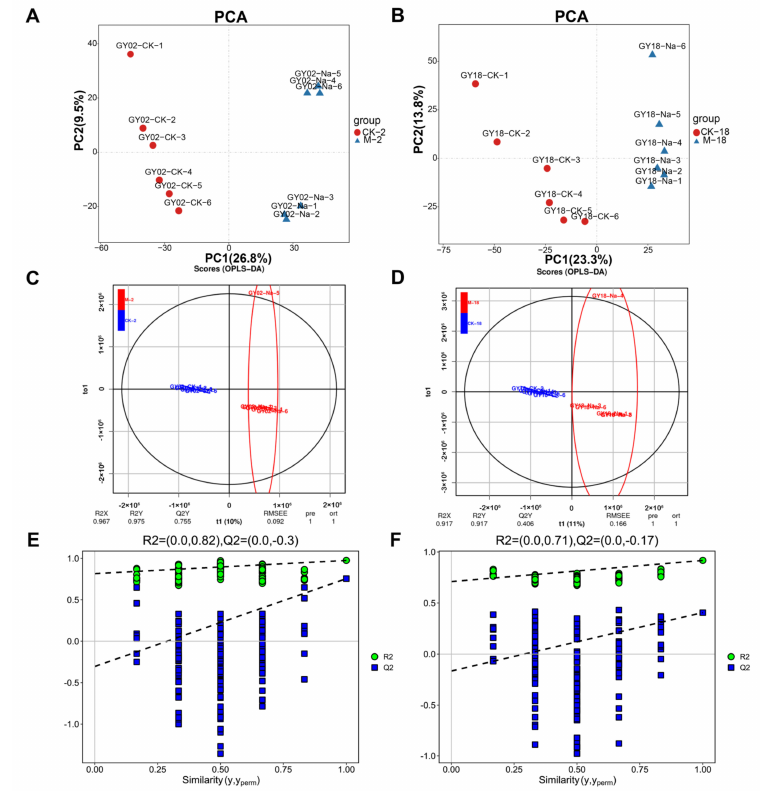
Figure 5. PCA score map ( A , B ), OPLS-DA scores ( C , D ) and permutation test ( E , F ) in positive ionization mode (POS). PCA score map of ( A ) GN2 and ( B ) GN18. ( C ) Scores of the OPLS-DA model in GN2 and ( D ) GN18. OPLS-DA cross-validation in ( E ) GN2 and ( F ) GN18. R 2 Y and Q 2 denote the rate of the model interpretation of the Y matrix and the predictive ability of the model, respectively. Q 2 > 0.9 indicates a good predictive model. The permutation test produces a distribution of R 2’ and Q 2’ values. A reliable model should produce much larger values of R 2’ and Q 2’ than a random model using the same dataset. Green and blue points indicate R 2’ and Q 2’ values, respectively.